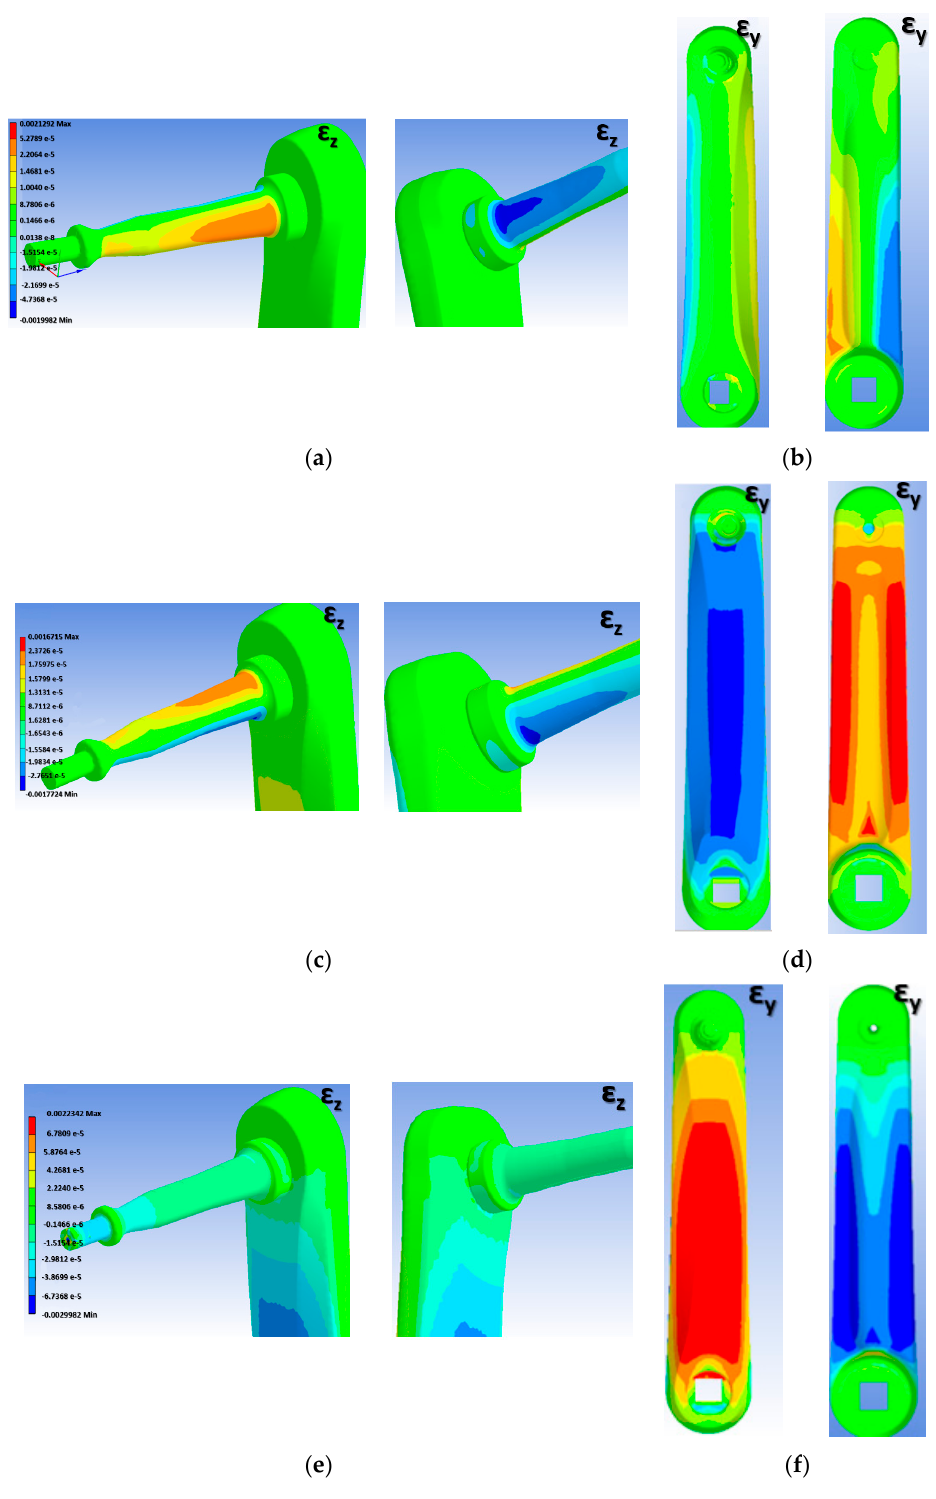
Figure 3. Pedal and crank strain mapping. ( a ) Strain in z direction ( ε z ) when F T is applied. ( b ) Strain in y direction ( ε y ) when F T is applied. ( c ) Strain in z direction ( ε z ) when F R is applied. ( d ) Strain in y direction ( ε y ) when F R is applied. ( e ) Strain in z direction ( ε z ) when F LM is applied. ( f ) Strain in y direction ( ε y ) when F LM is applied.